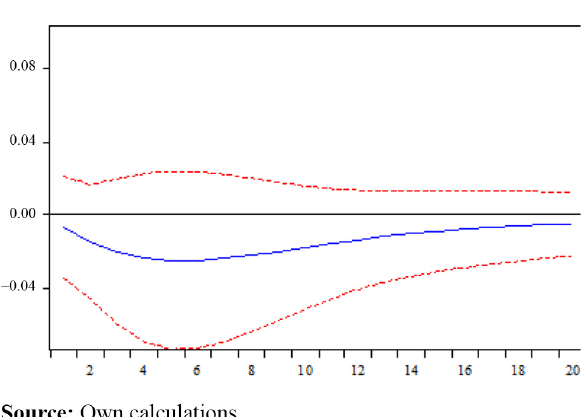
Figure 11. Response of LGDP to